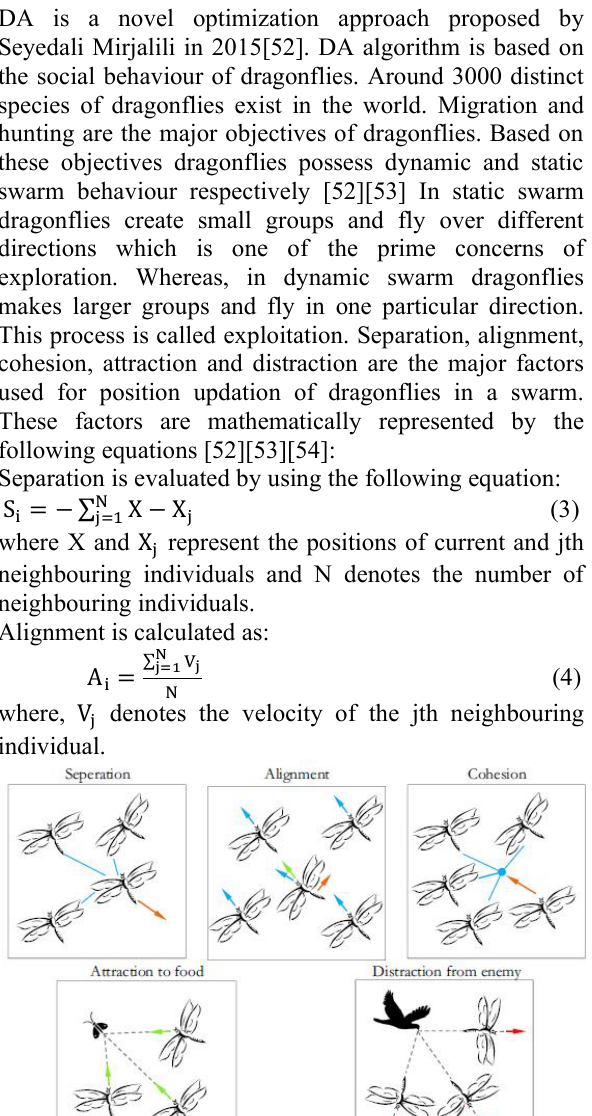
In BOA butterflies propagate the information by sensing the fragrance. Butterflies move in a random direction if they are not capable of sensing the fragrance otherwise they move towards the best species if